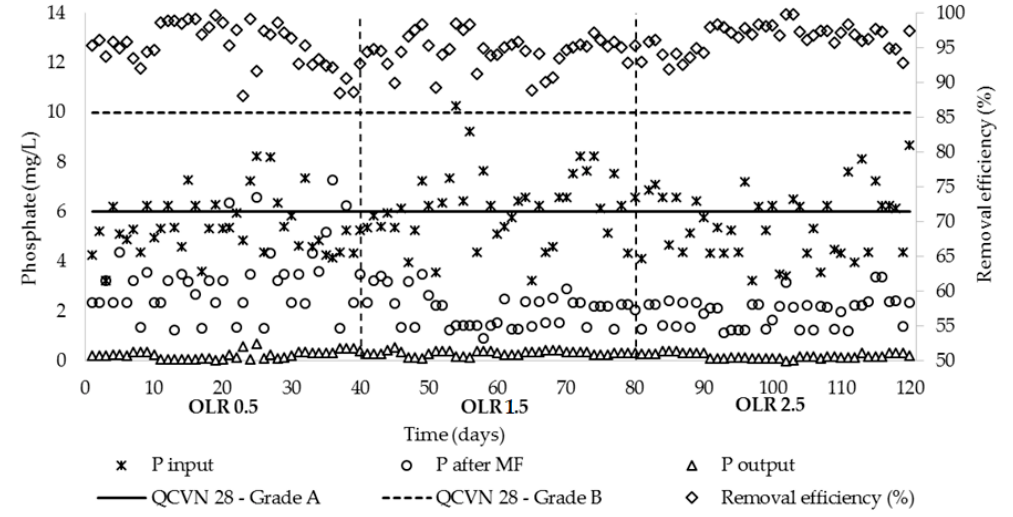
Figure 5. The total phosphate (TP) removal efficiency at three organic load rates in duration 120 days of MBR-NF system.